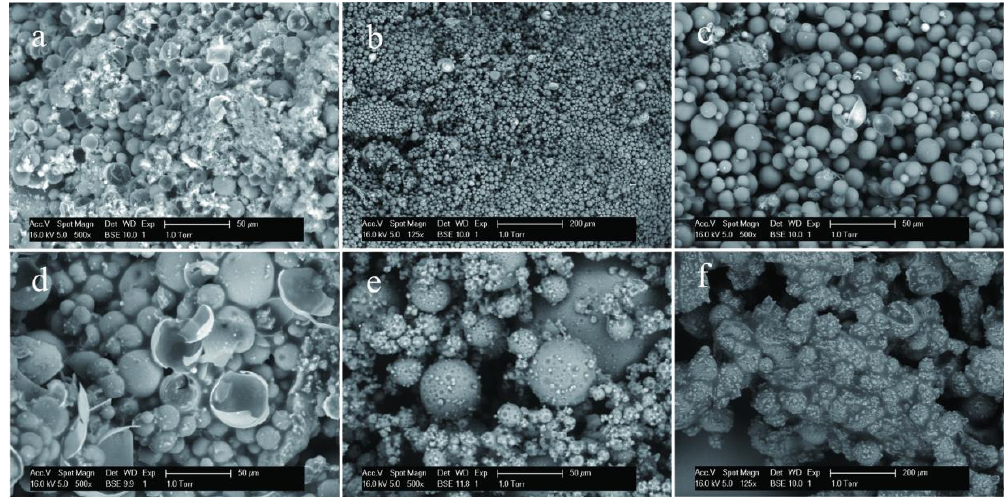
Figure 3. SEM morphologies of self-healing microcapsules with difference contents of graphene in